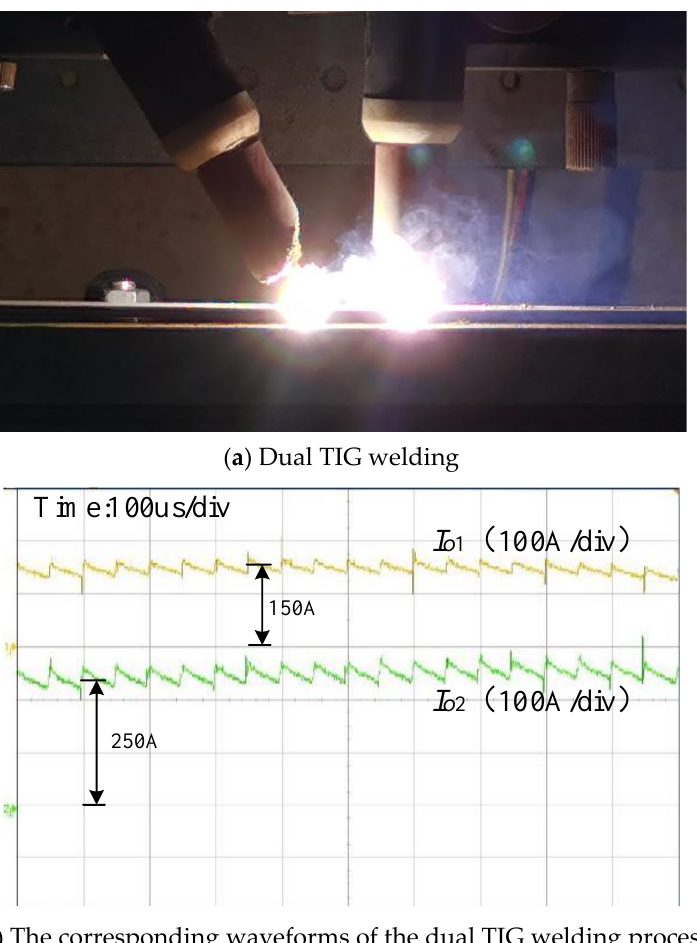
Figure 14. Actual welding